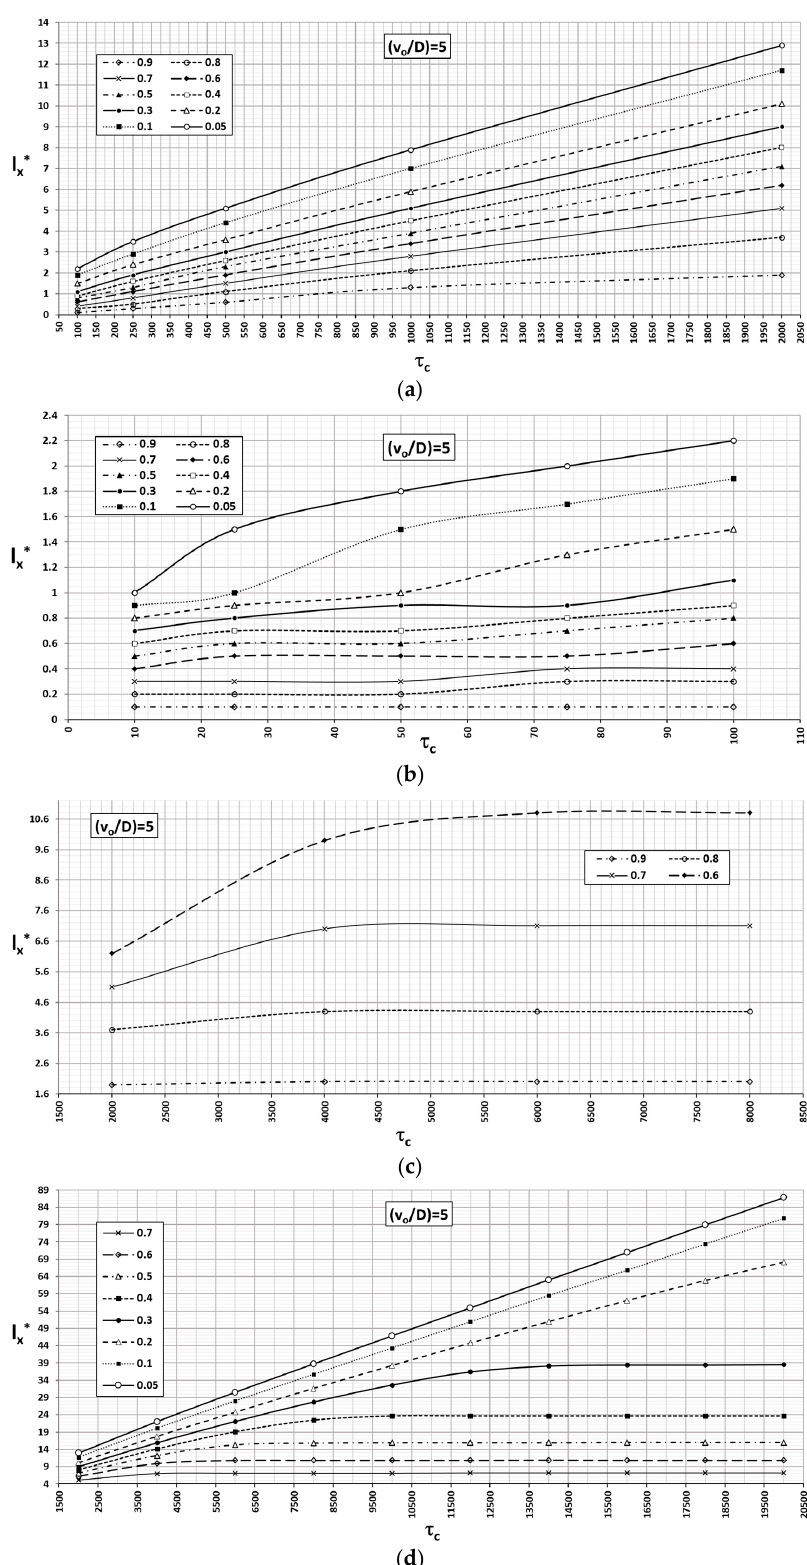
Figure 10. Universal curve l ∗ as a function of time factor τ c . Parameter of the abacus v o x ( c (cid:48) ) v o = 0.0006 m/d. ( a ) τ c ∈ [100–2000 days], ( b ) τ c ∈ [10–100 days], ( c ) τ c ∈ [2000–8000 days], ( d ) τ c ∈ [2000–20,000